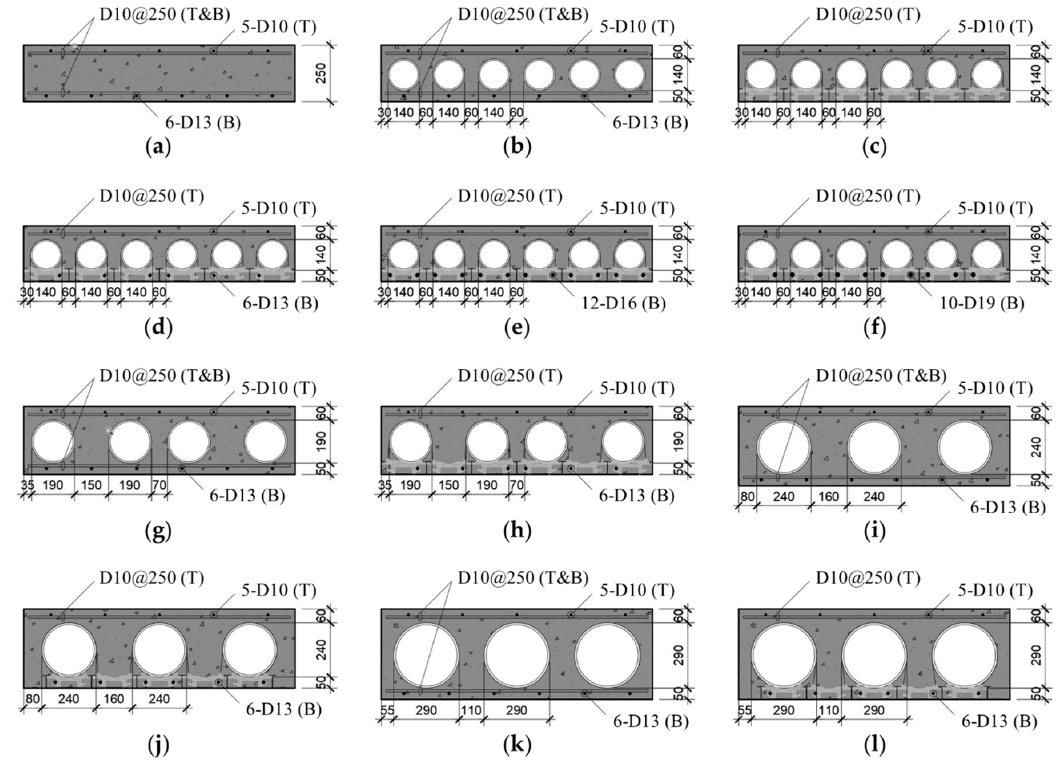
Figure 4. Cross-section details of specimens (all dimensions in mm): ( a ) S250P; ( b ) V250P; ( c ) TD250P1; ( d ) TD250P2; ( e ) TD250P3; ( f ) TD250P4; ( g ) V300P; ( h ) TD300P; ( i ) V350P; ( j ) TD350P; ( k ) V400P; ( l )